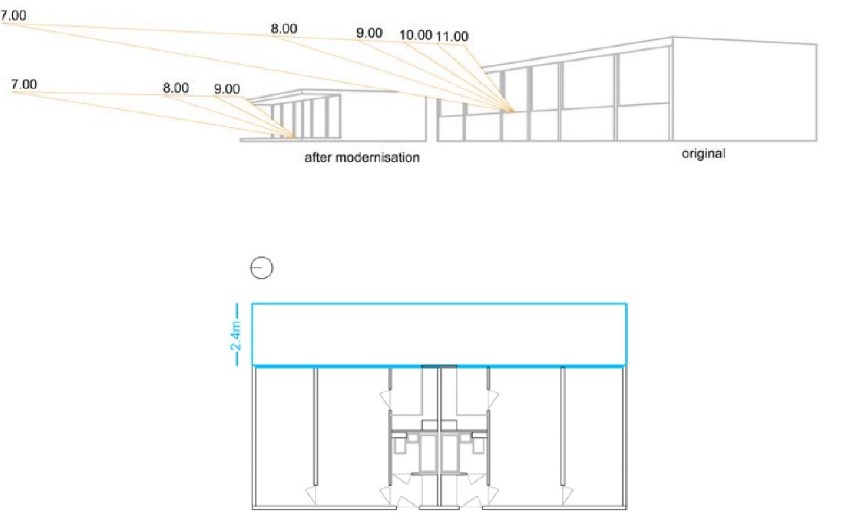
Figure 9. Analysis of direct sun exposure in WWP building. In the original version, direct light is provided on the days of the equinox between 7 a.m. and noon. In the potentially modernized version, direct light is provided between 7 a.m. and 10 a.m. Drawing by the author. Enlarging the windows in the building does not increase access to light. The potential expansion shortens the access time to direct sunlight by 2 h. The same analysis for the southern façade in the OWT-67 building showed that the depth of the winter garden with the terrace could be 3.2 m max. Following Polish law, the depth of the added structure in the WWP buildings is 60 cm (20%) lower than in Tour Bois le Prêtre. Such a limitation